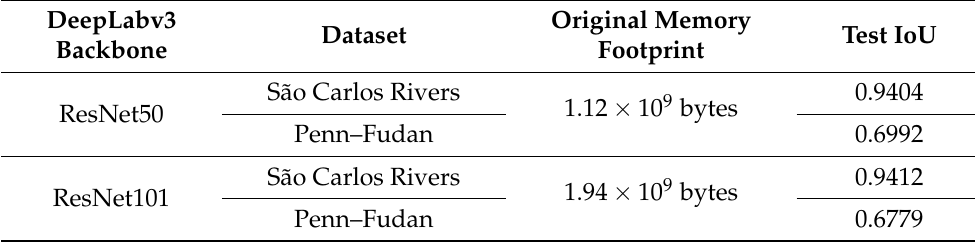
Table 1. Memory footprint and test IoU of the original DeepLabv3 models.